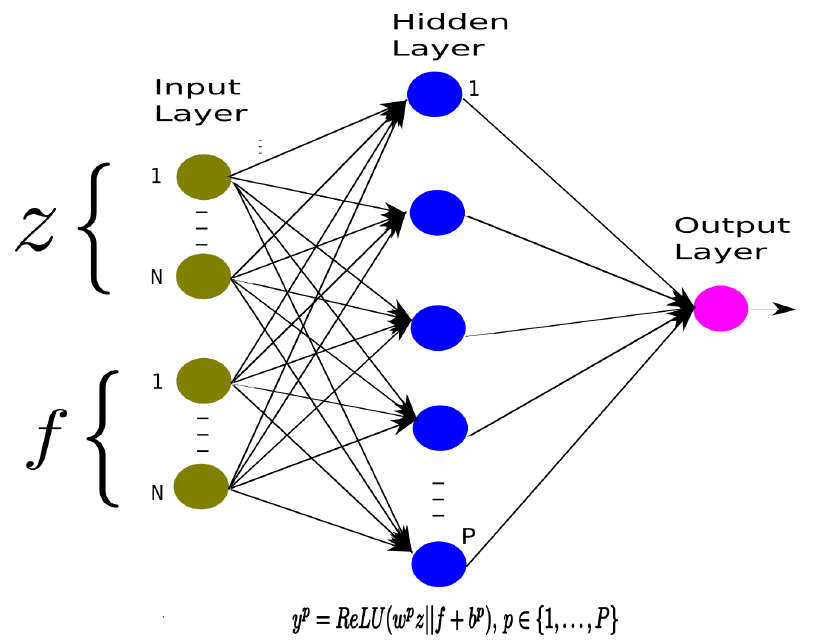
Figure 1. Fully connected neural network with one hidden layer and linear output.